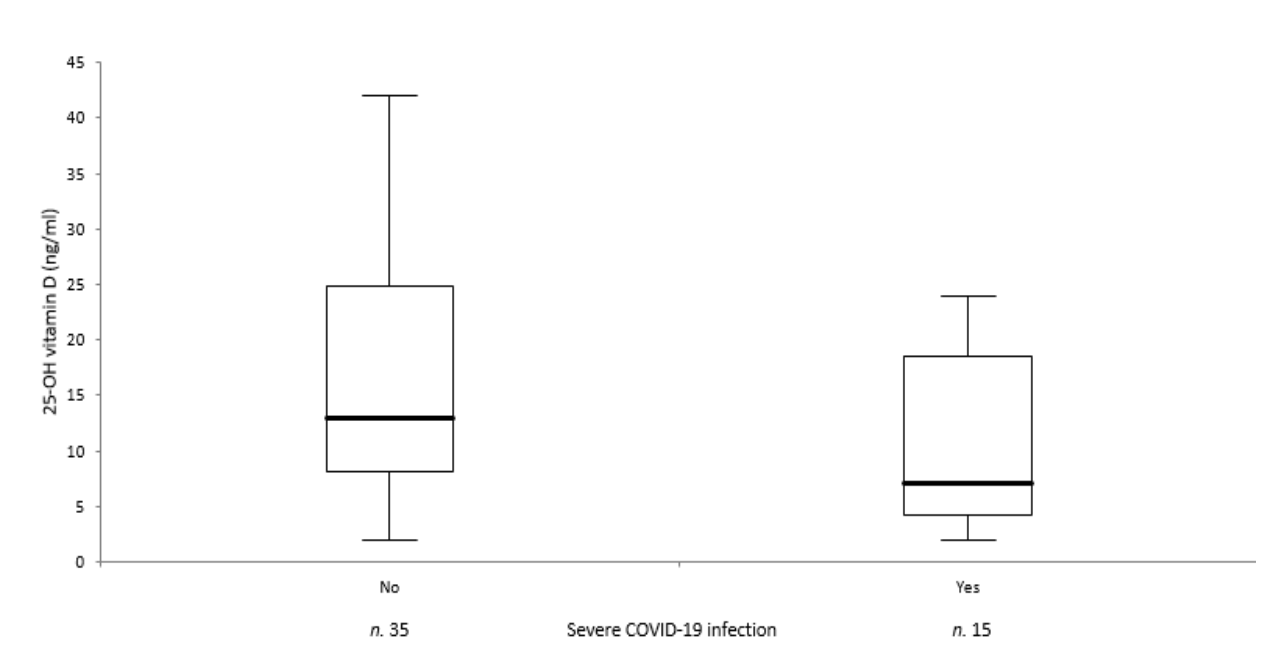
Figure 1. Analysis of variance (ANOVA) displayed as box-plot of serum 25-OH vitamin D levels in patients according to oxygen therapy/ventilatory support ( p = 0.75). HFNC: high-flow nasal cannula; cPAP: continuous positive airway pres- sure; NIV: non-invasive ventilation.